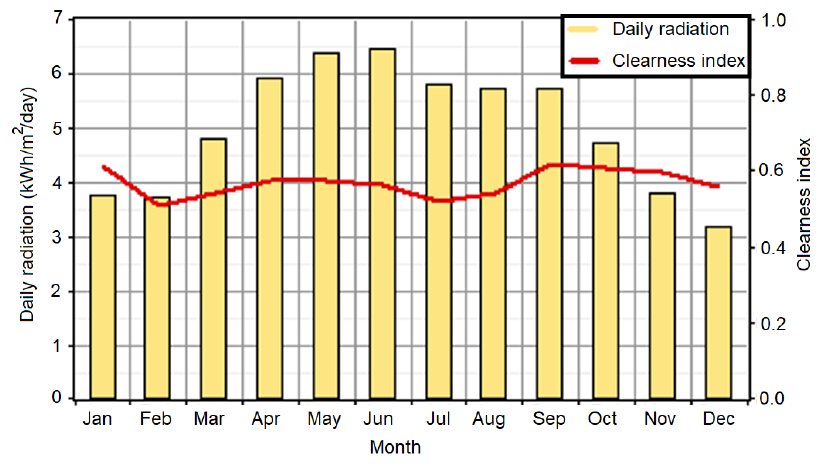
Figure 8. Monthly solar energy resource in Grand Canary [47].